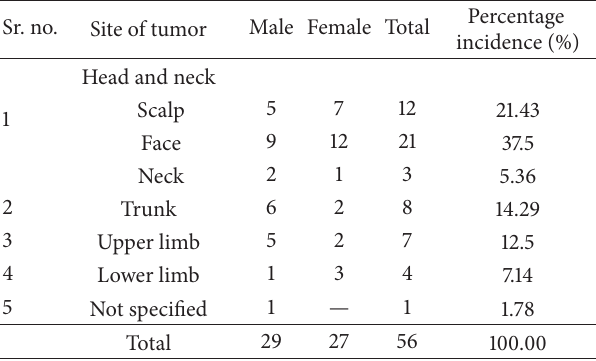
Table 2: The site and sex distribution of observed adnexal tumors. Sr.